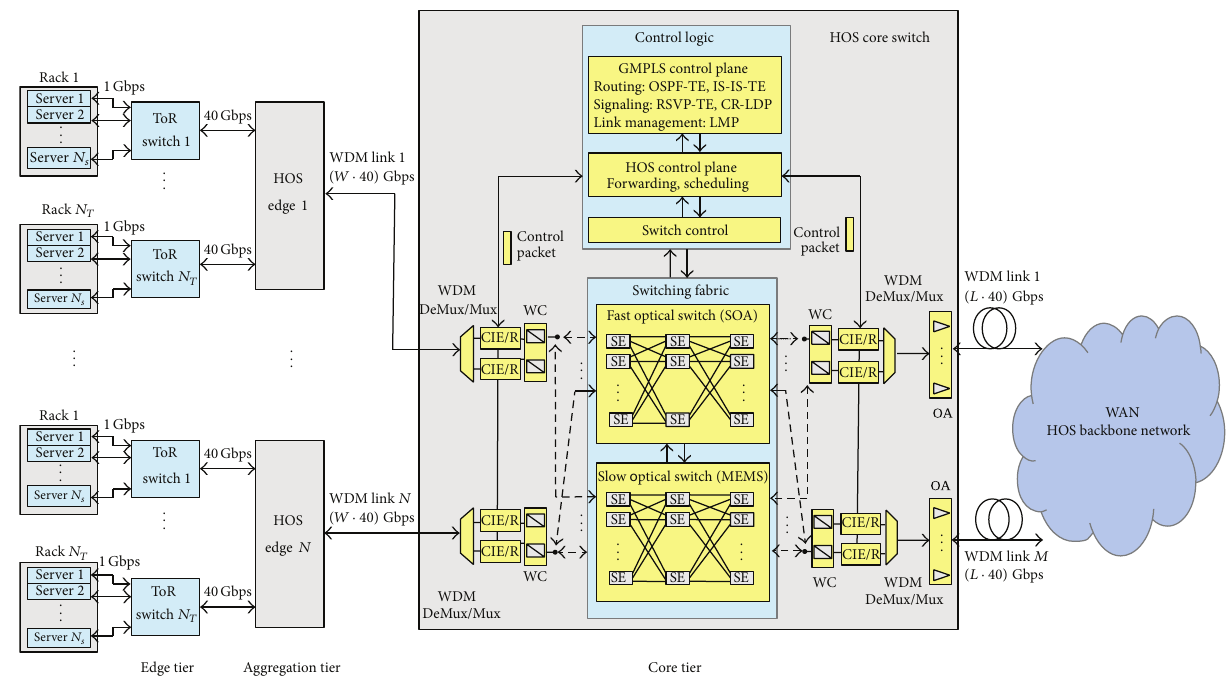
Figure 2: Architecture of a data center employing a HOS interconnection network. CIE/R: control information extraction/reinsertion, WC: wavelength converters.